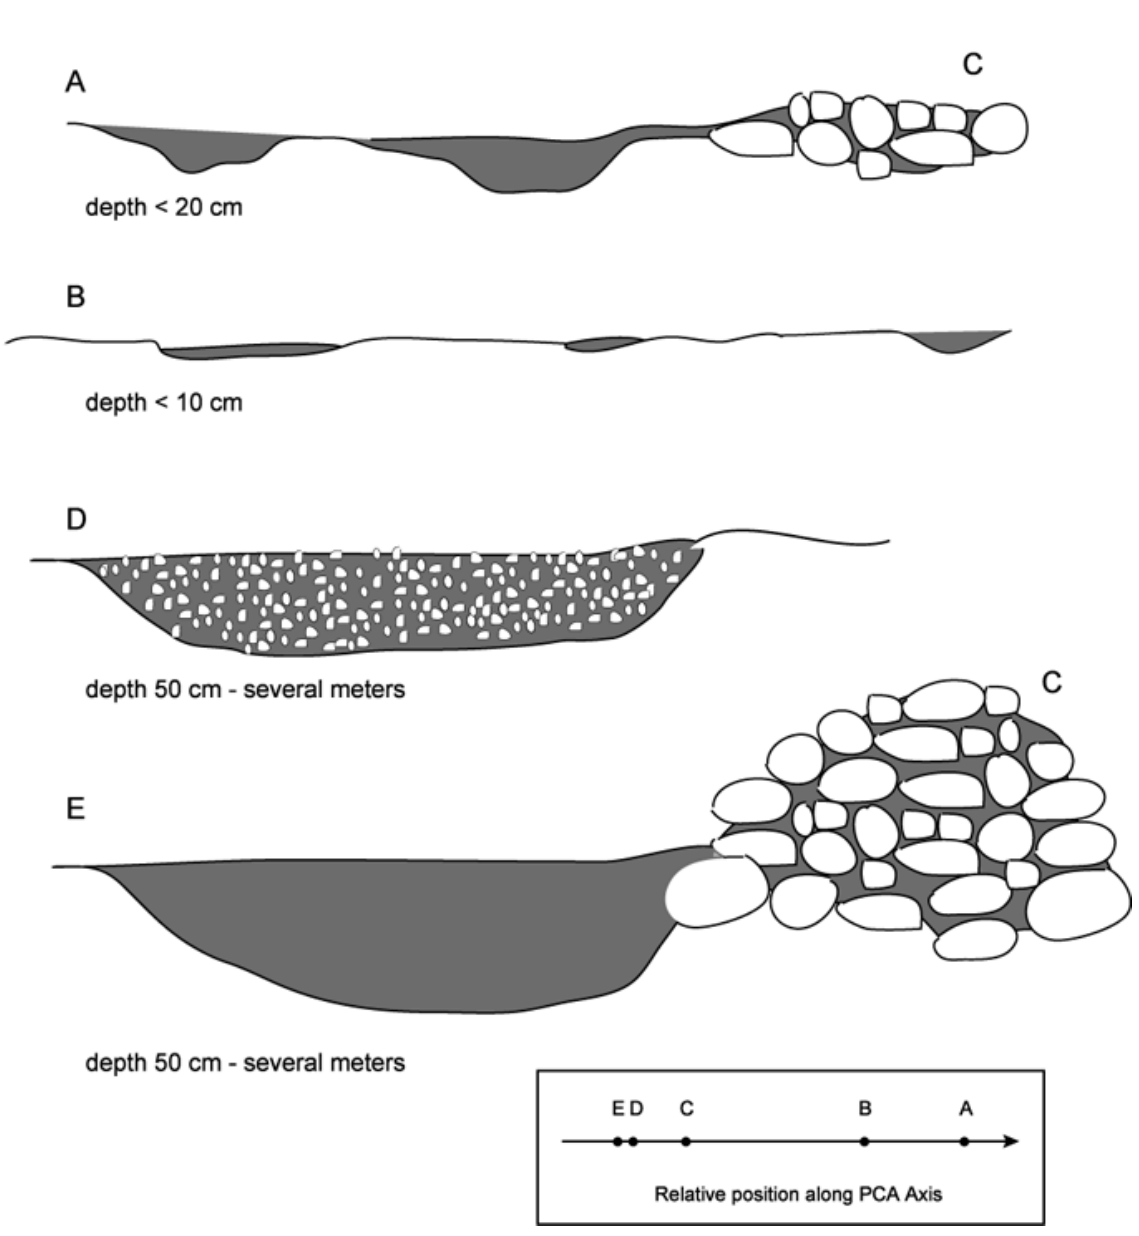
Fig. 3. Schematic representation of Maya substrate types used to describe variation in edaphic conditions in this study. Grey fill indicates zones of soil accumulation. Local names are A= kon kon lu’um , B= laja or tsek’el , C= wool wool tunich , D= ch’iich lu’um , E= k’ankab . Types A—C tend to have high organic content, whereas types D and E tend to be redder in color, corresponding roughly to lithosols and rendzinas, respectively (Weisbach et al. 2002). The inset shows the relative position of each substrate type along the PCA axis, which we defined as our rockiness index, ranging from sites with a high proportion of plots with less rocky types D and E, to those with a high proportion of plots with rockier types A and